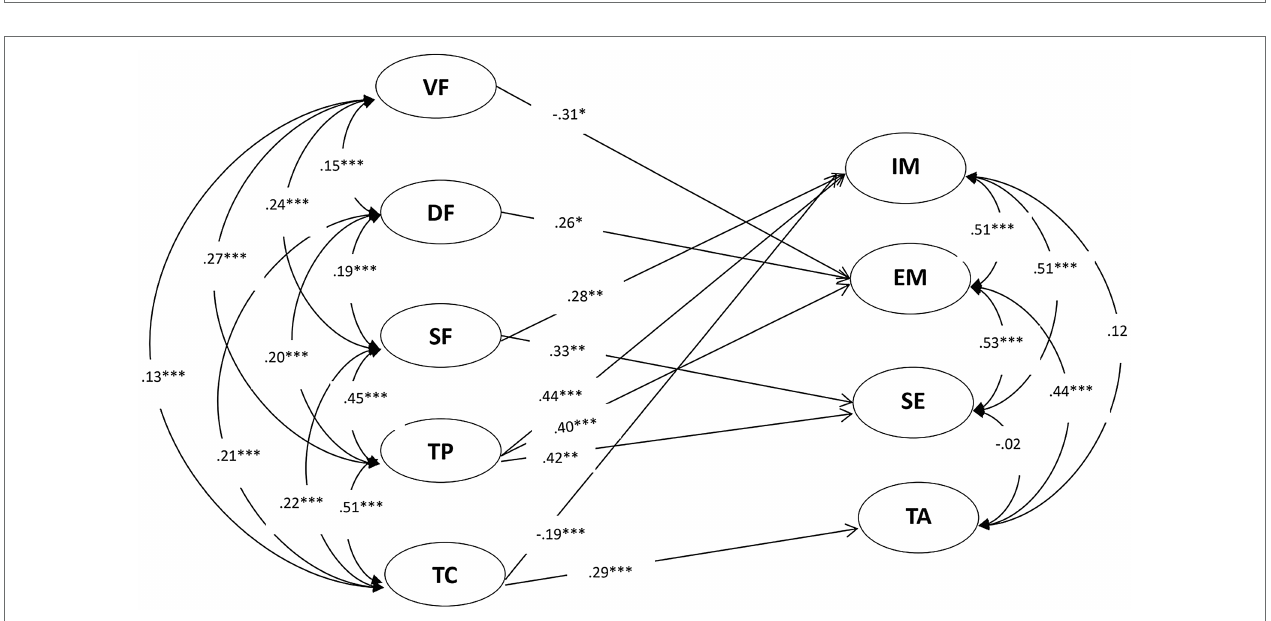
FIGURE 3 | Relationships between male students’ perceptions of teacher feedback and their motivation in language. * p < 0.05, ** p < 0.01 and *** p < 0.001. VF, verification feedback; DF, directive feedback; SF, scaffolding feedback; TP, teacher praise; TC, teacher criticism; IM, intrinsic motivation; EM, extrinsic motivation; SE, self-efficacy and TA, test anxiety.